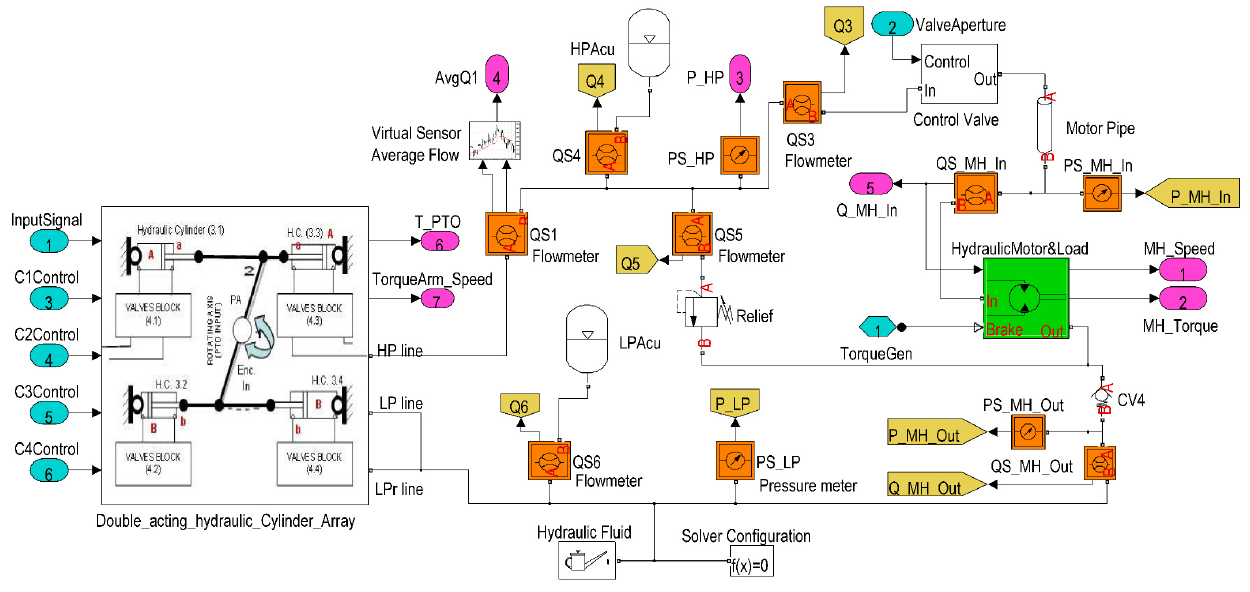
Figure 8. PTO hydraulic model